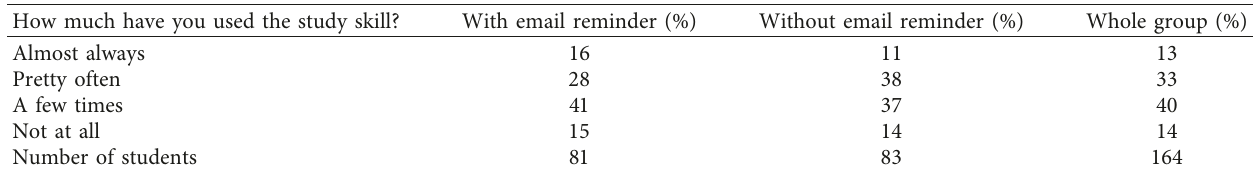
Table 7: Sum over all skills of how much the study skill was used. Comparison in the postquestionnaire between the group receiving weekly email reminders and the group not receiving reminders. How much have you used the study